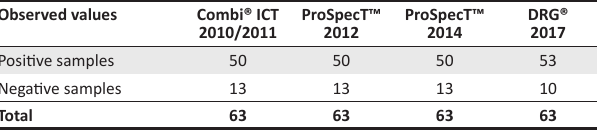
TABLE 1: Comparison of enzyme immunoassay kits and rapid test strip